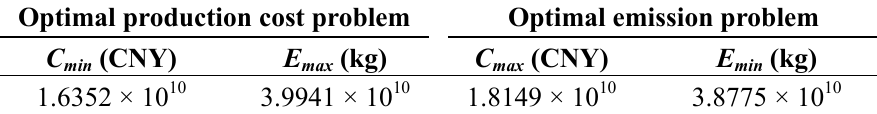
Table 3. Optimal cost and emission.